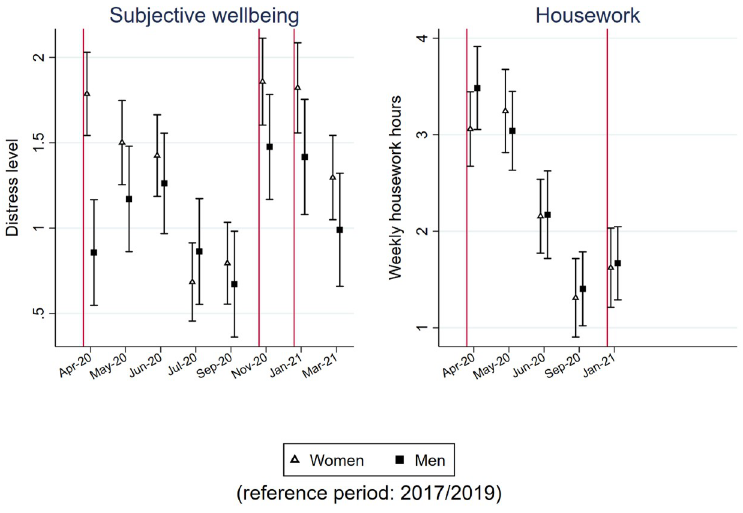
Fig 5. Point estimates and 95% confidence interval of the gender-period interaction models to predict subjective wellbeing and housework time.